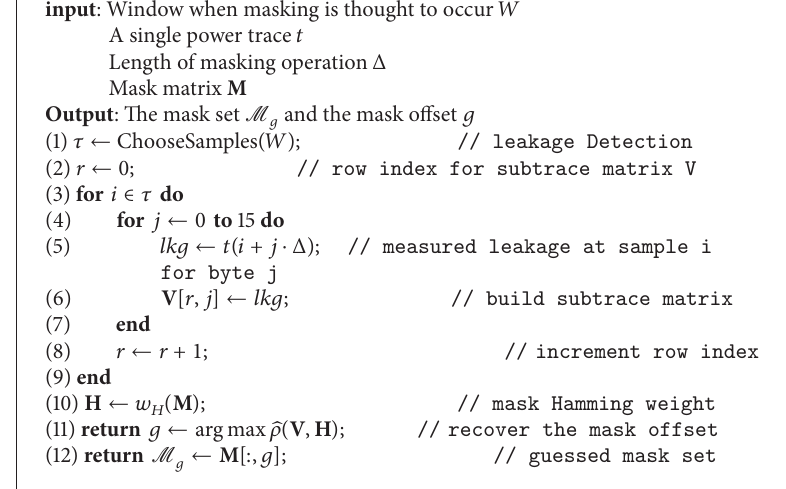
Algorithm 1: Mask recovery.